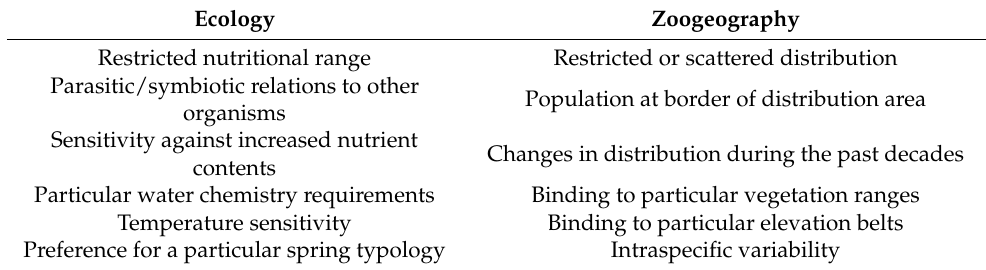
Table 2. Criteria for the selection of reference